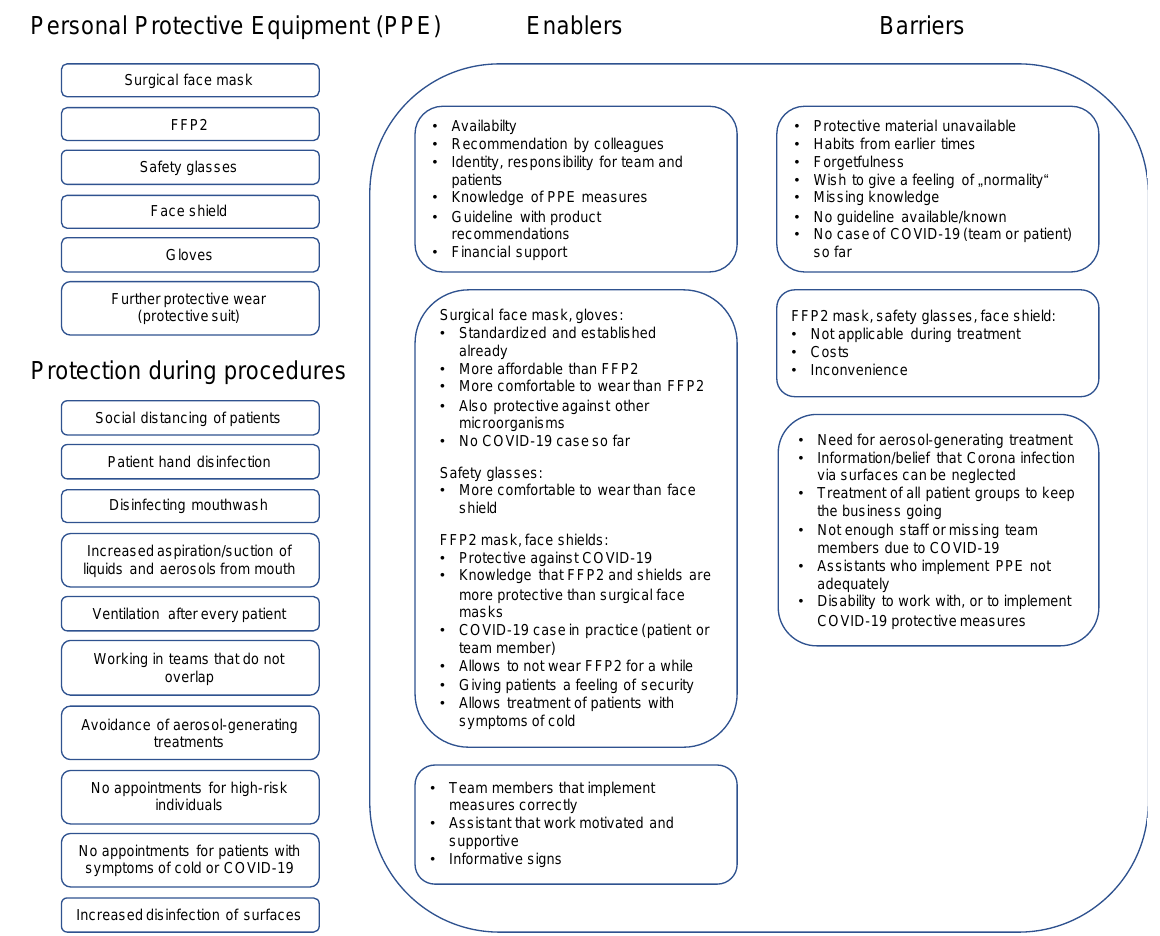
Figure 4. COVID-19 infection control measures and associated enablers and barriers. The infection control measures are subdivided into personal protective equipment (PPE) and protective measures during working procedures in dental practice ( left ). Enablers and barriers for the implementation of these measures are shown in the right boxes. The first sub-box provides general enablers or barriers. The second sub-box refers enablers and barriers to PPE and the third sub-box to enablers and barriers to protection during procedures.